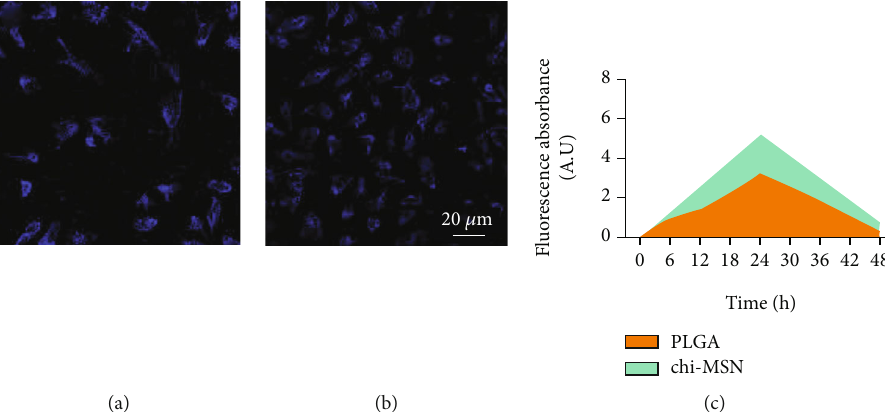
Figure 3: In fi ltration ability of BMP-2@Chi-MSN in bone marrow tissue. (a) In fi ltration ability of PLGA in bone marrow tissue. (b) In fi ltration ability of Chi-MSN in bone marrow tissue. (c) Quantitative fl uorescence evaluation in bone tissue after adding fl uorescein- coupled PLGA and